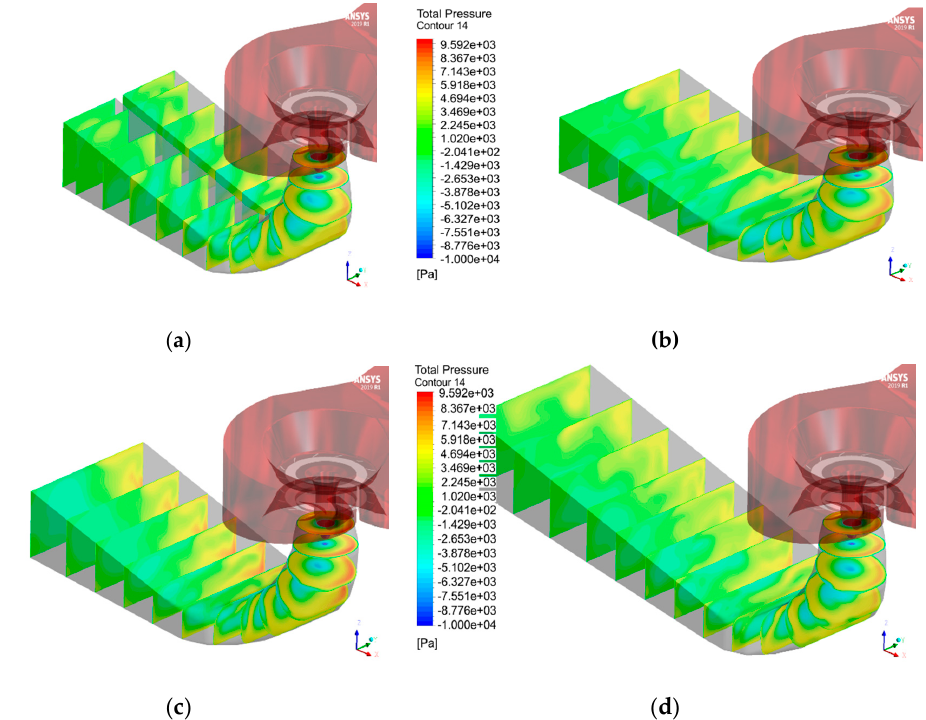
Figure 12. Comparison of relative total pressure distributions: ( a ) Baseline; ( b ) Candidate 1; ( c ) Candidate 2; ( d ) Candidate 3.